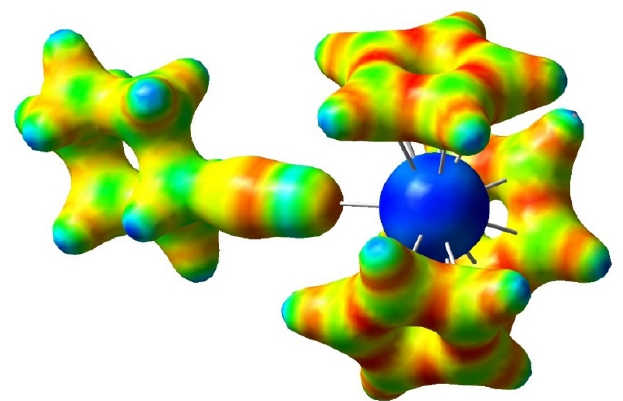
Figure 6. Electrostatic potential (ESP) map of (Cp) 3 La(C ≡ NCy) with density isovalue of 0.11 au; red—mostly negative and blue—mostly positive.